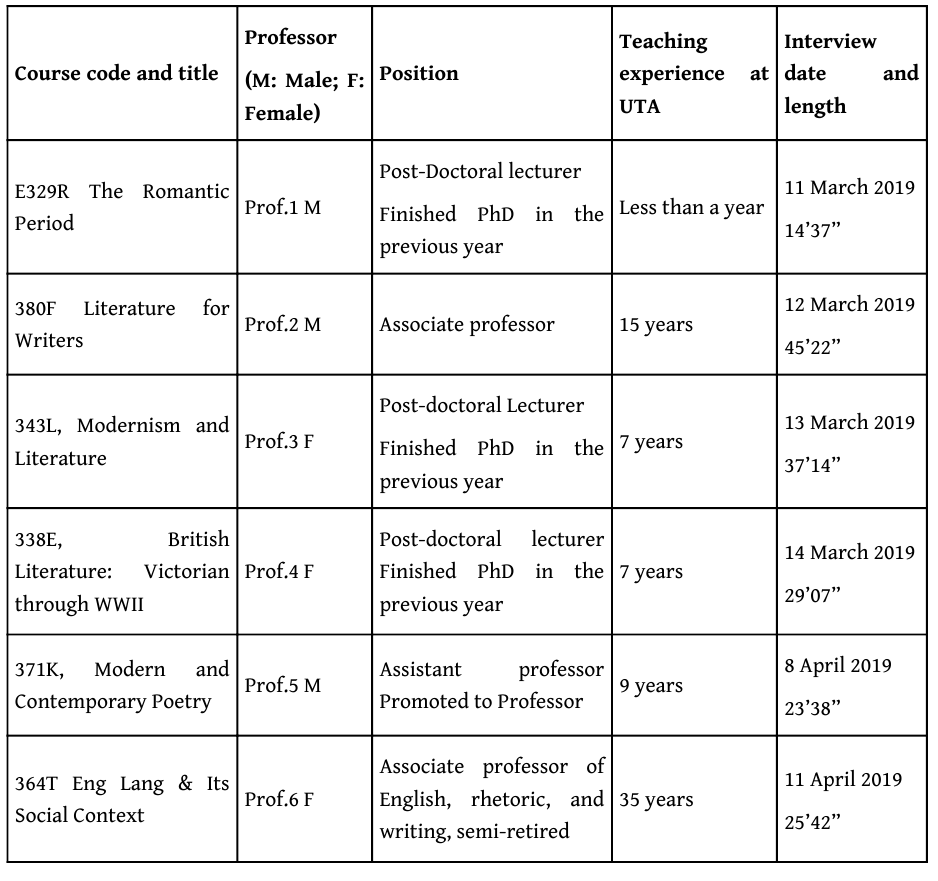
Course code and